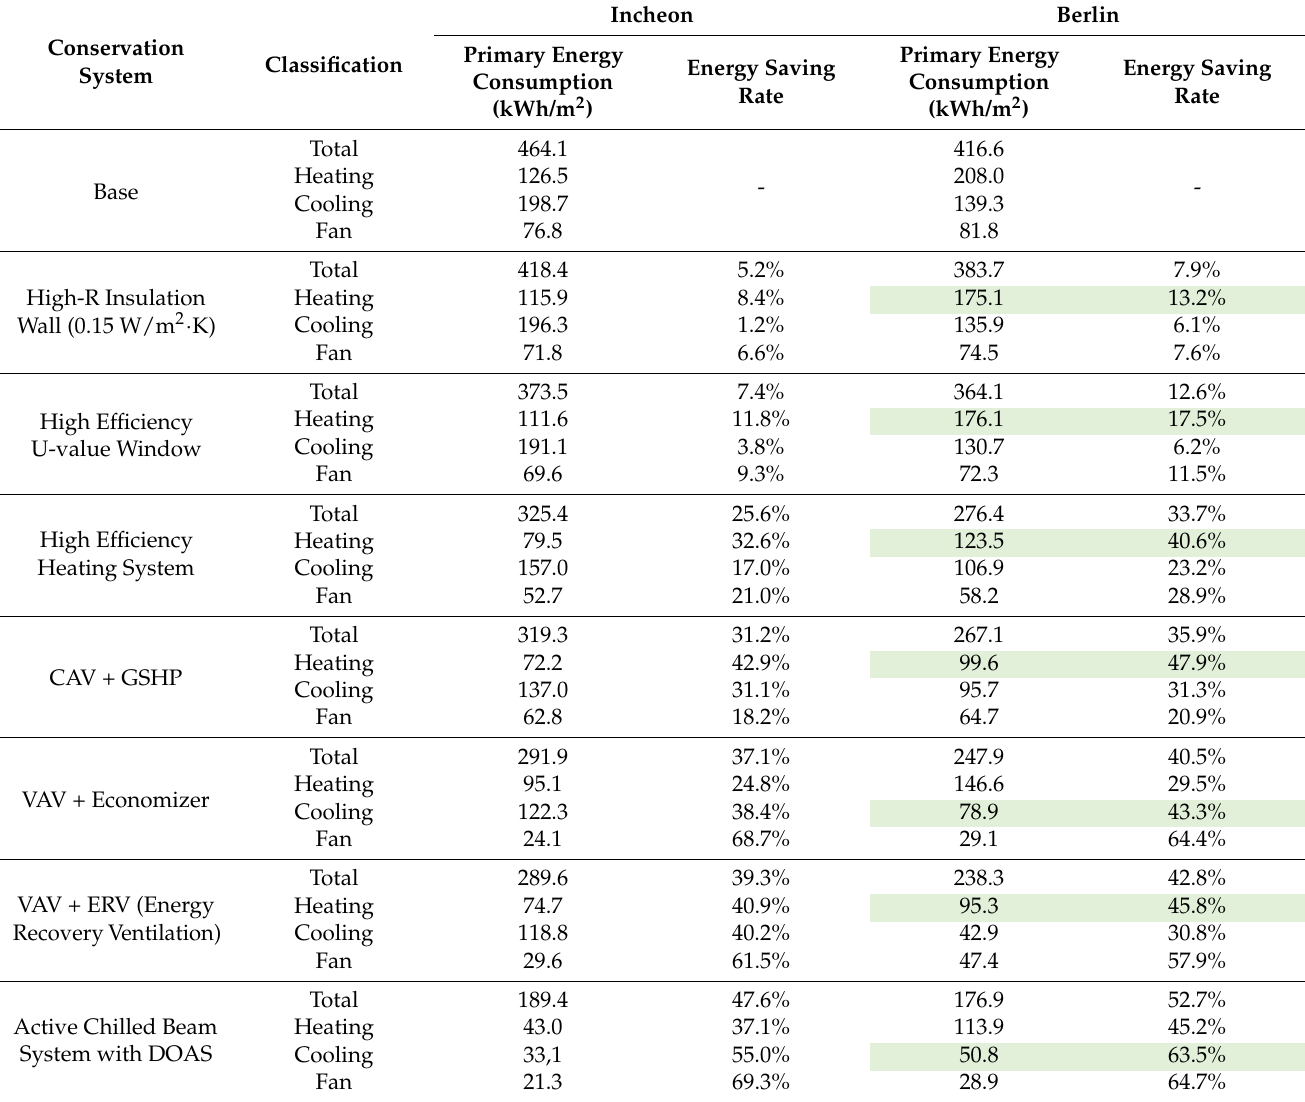
Figure A3. Primary energy consumption and energy saving potential (%)—Berlin. Table A1. Breakdown of the energy consumption and saving rate (comparison of Incheon and